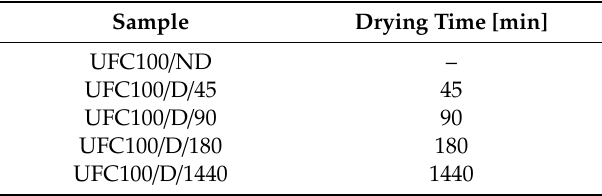
Table 1. Drying times of cellulose fibers: D—dried; ND—not-dried. Sample